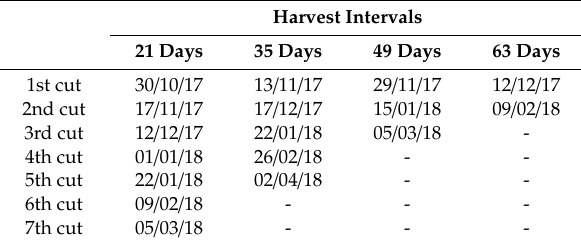
Table 2. Days in which field measurements and unmanned aerial vehicle (UAV) flights were carried out. Harvest Intervals